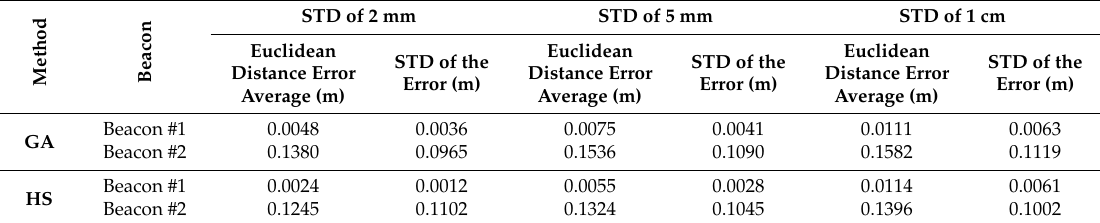
Table 5. Results according to different values of the standard deviation related to the distance measuring noise.